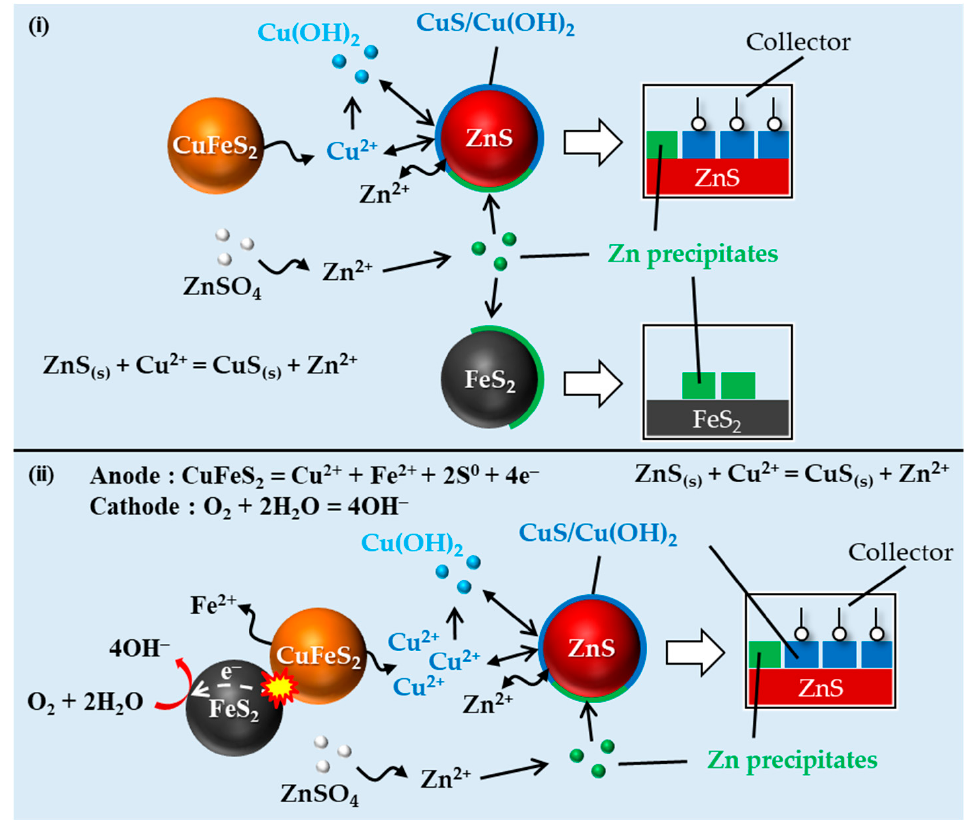
Figure 9. A schematic diagram of two possible mechanisms for why pyrite inhibits the depression of sphalerite with zinc sulfate in the presence of chalcopyrite: ( i ) the reduced amount of zinc precipitates adsorbed onto the surface of sphalerite due to the presence of pyrite whose surface also attracts zinc precipitates, ( ii ) galvanic interaction between chalcopyrite and pyrite that promotes the anodic half-cell reaction of chalcopyrite, releasing more Cu 2+ into the aqueous solution.